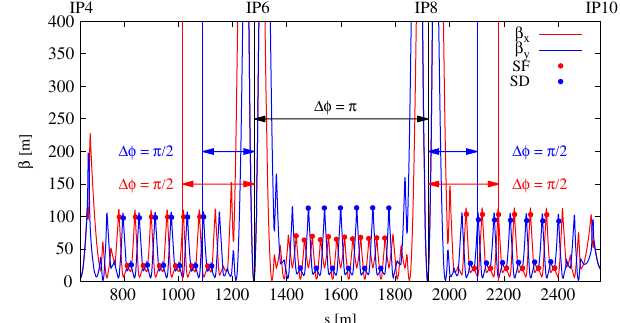
FIG. 5. RHIC Blue ring ATS lattice for 100 GeV protons. Only a fraction of the 3.8 km circumference is